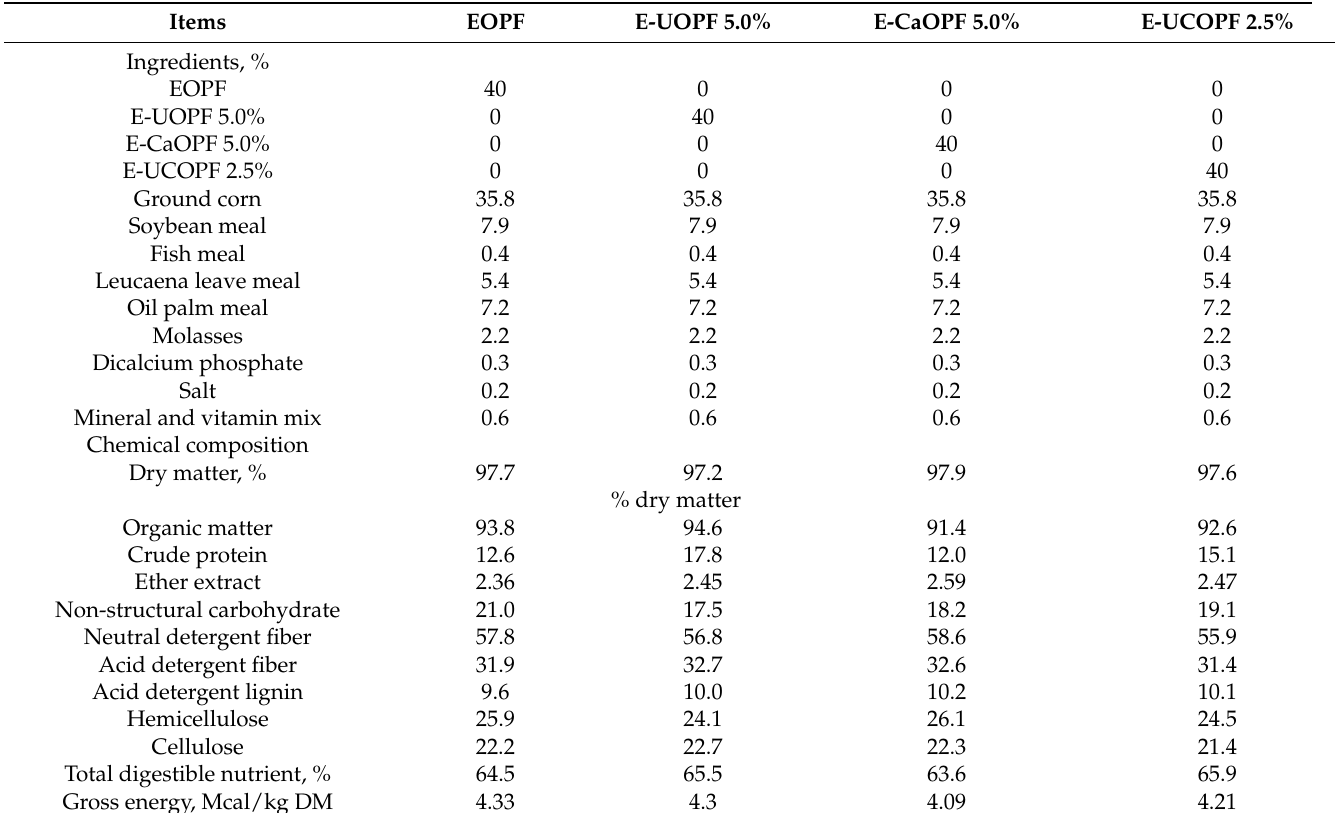
Table 1. Ingredients and chemical composition of the total mixed rations (TMR), EOPF, E-UOPF 5.0%, F-COPF 5.0%, and E-UCOPF 2.5% used in the experiment (DM